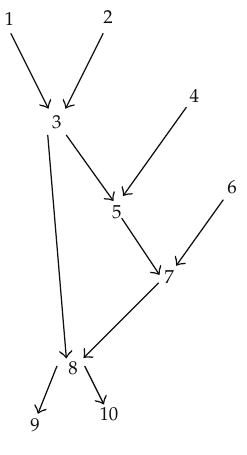
Figure 1: An example of a Bayesian network.